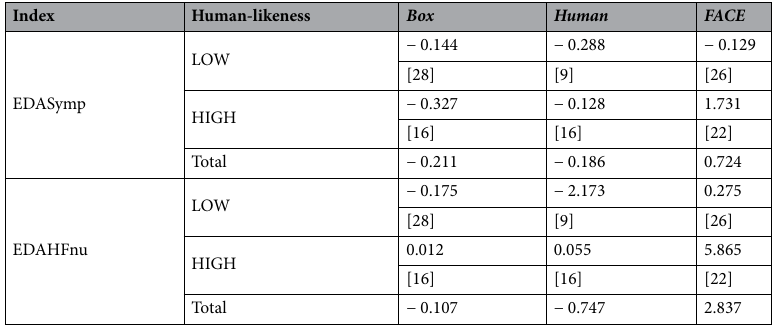
Table 5. Physiological data: EDAsymp and EDAhf_nu. The EDAsymp index quantifies the activity of the sympathetic nervous system, while the EDAHFnu index quantifies the sympthovagal balance. A full description is available in the sections Description and analysis of physio data and New index from the sympathovagal assessment in Methods. Human-likeness is Low when the participant rating is in the lower side of the distribution on the 7-likert scale, and High otherwise. The number of observations are in squared brackets.